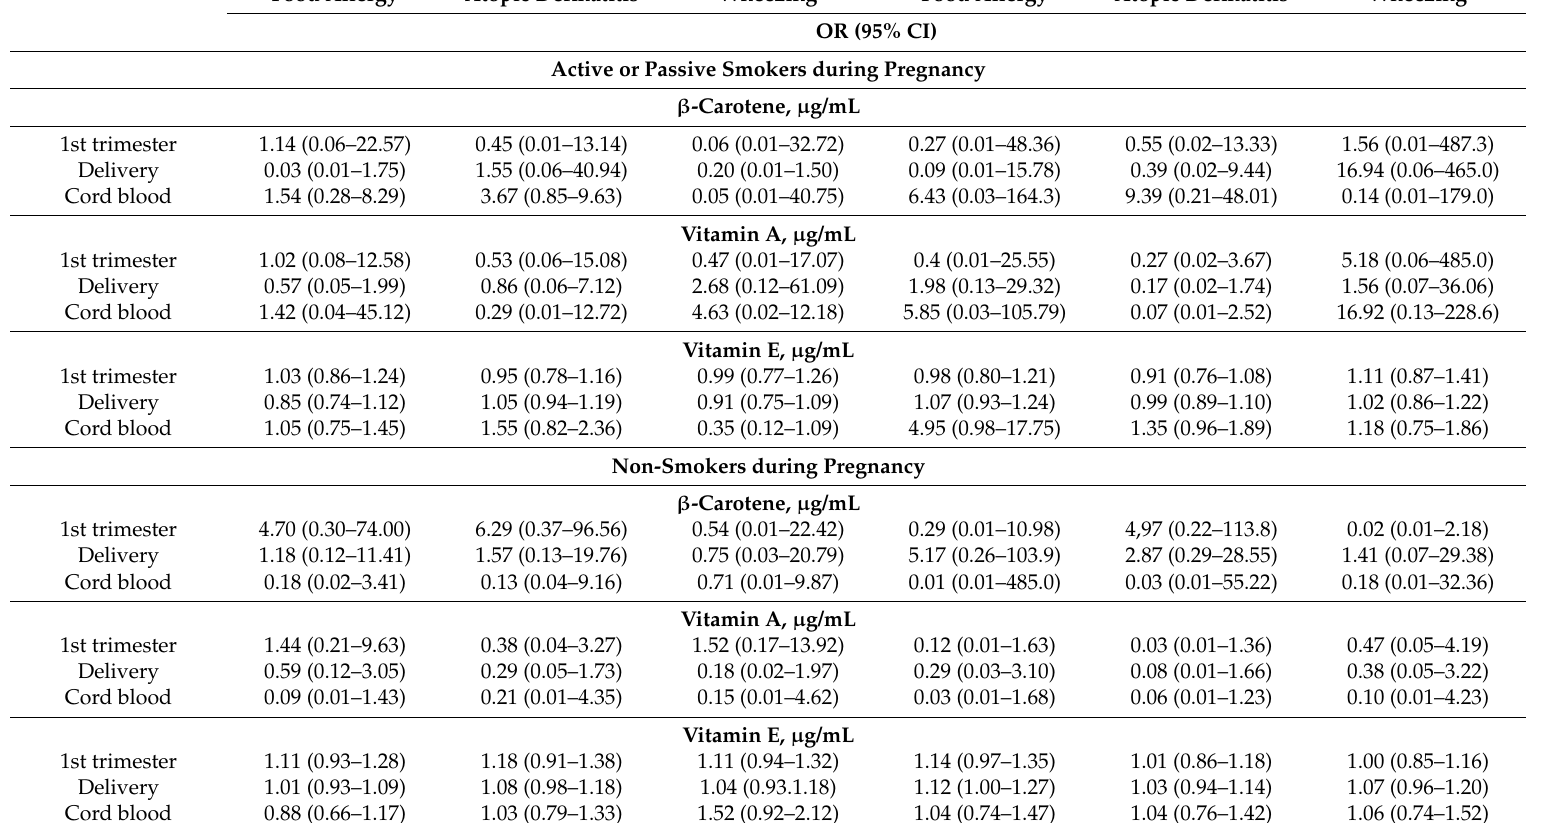
Adjusted for: molds at home, cleaning frequency, pets at home, maternal socio-economic status and education, child gender, parental atopy, breast feeding and living area. p for interaction